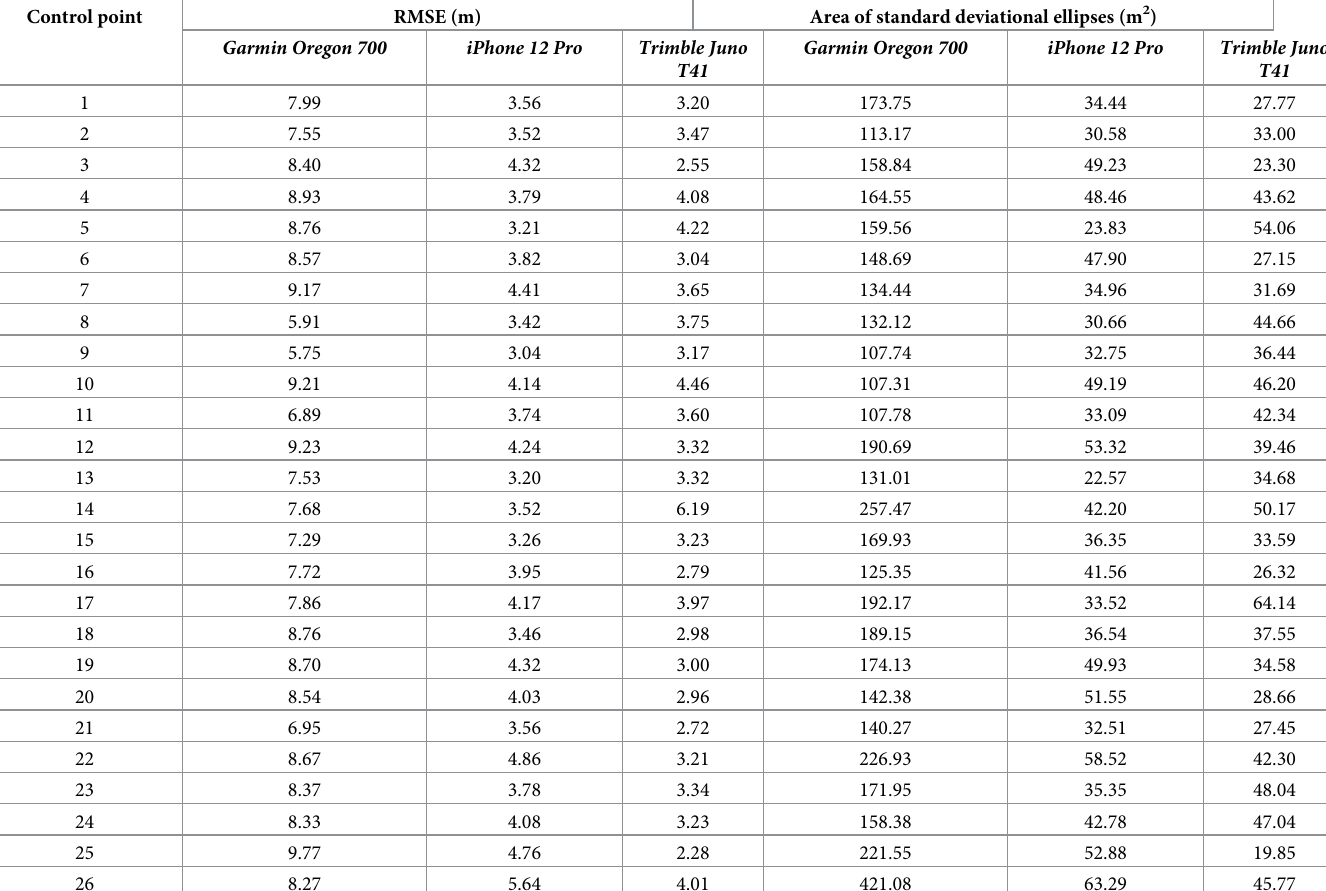
Table 3. The positional error (root mean square error, RMSE) and the area of standard deviational ellipses observed by different GNSS receivers at each control